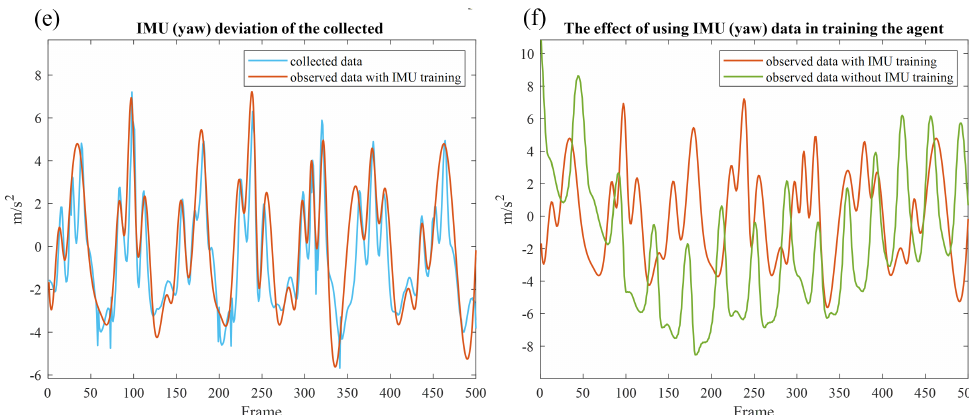
Figure 8. The IMU deviation of the collected IMU data from the observed IMU data (m/s 2 ) for the first 5 s of the simulation is shown on the vertical axes, and the horizontal axes show the 500 frames of the timesteps (0.01 s): ( a ) roll, RMSE = 0.8824 ( c ) pitch, RMSE = 0.5825 ( e ) yaw, RMSE = 1.5908. Roll ( b ), pitch ( d ), and yaw ( f ) directions are used to demonstrate the difference in walking directions between an agent trained with IMU data (orange) and an agent trained without IMU data